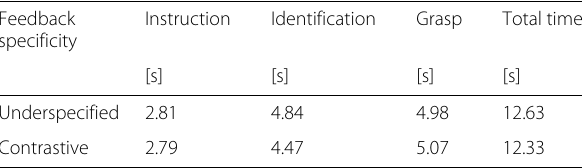
Table 2 Mean durations of the three interaction phases and the total time for Experiment